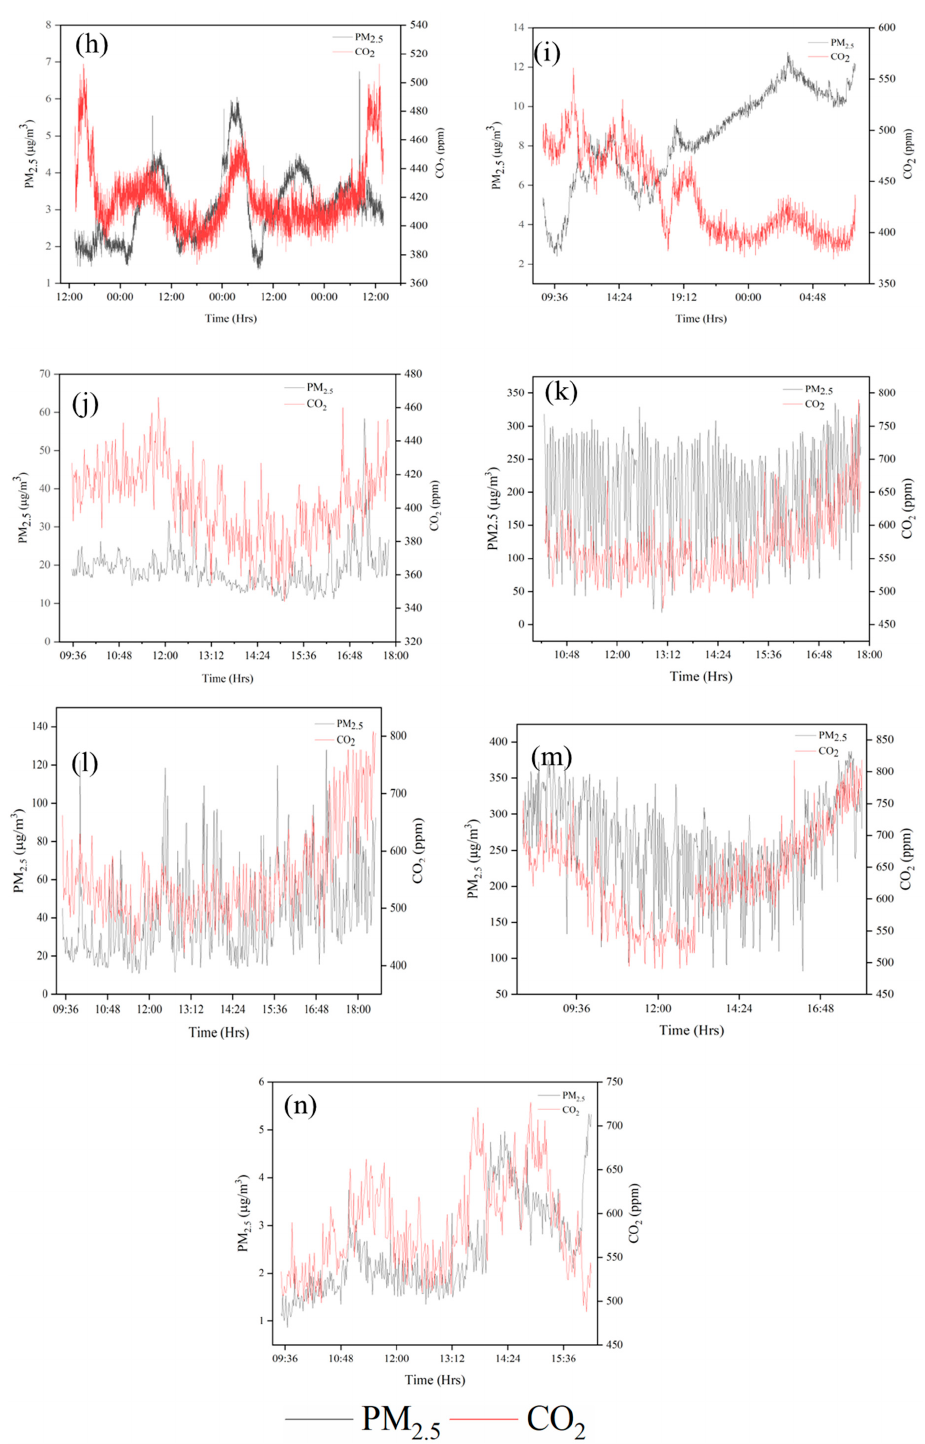
Figure 3. Time series of PM 2.5 and CO 2 at all sampling sites ( a ) PR; ( b ) HS1-RW; ( c ) HS1-ICU; ( d ) HS2-ICU; ( e ) SCH; ( f ) HS3-MDU; ( g ) HS4-EOM; ( h ) RI; ( i ) HS5-OPR; ( j ) TSM; ( k ) UG-S1; ( l ) UG-S2; ( m ) UG-S3; ( n ) HS1-AER. As an example, the concentration values of the first sampling run are shown in the